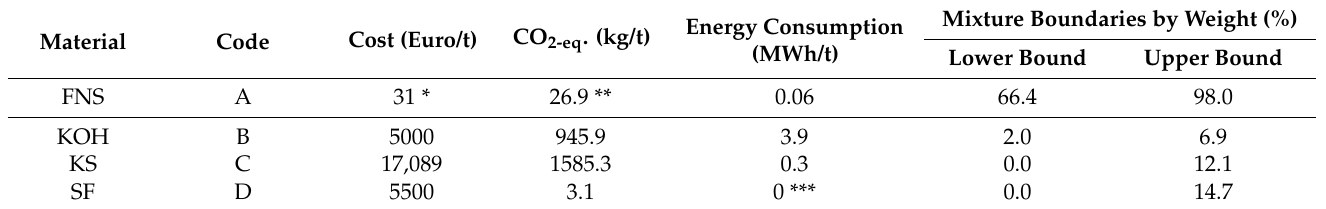
Table 2. Cost, CO 2-eq. , energy consumption, and DOE boundaries for each binder